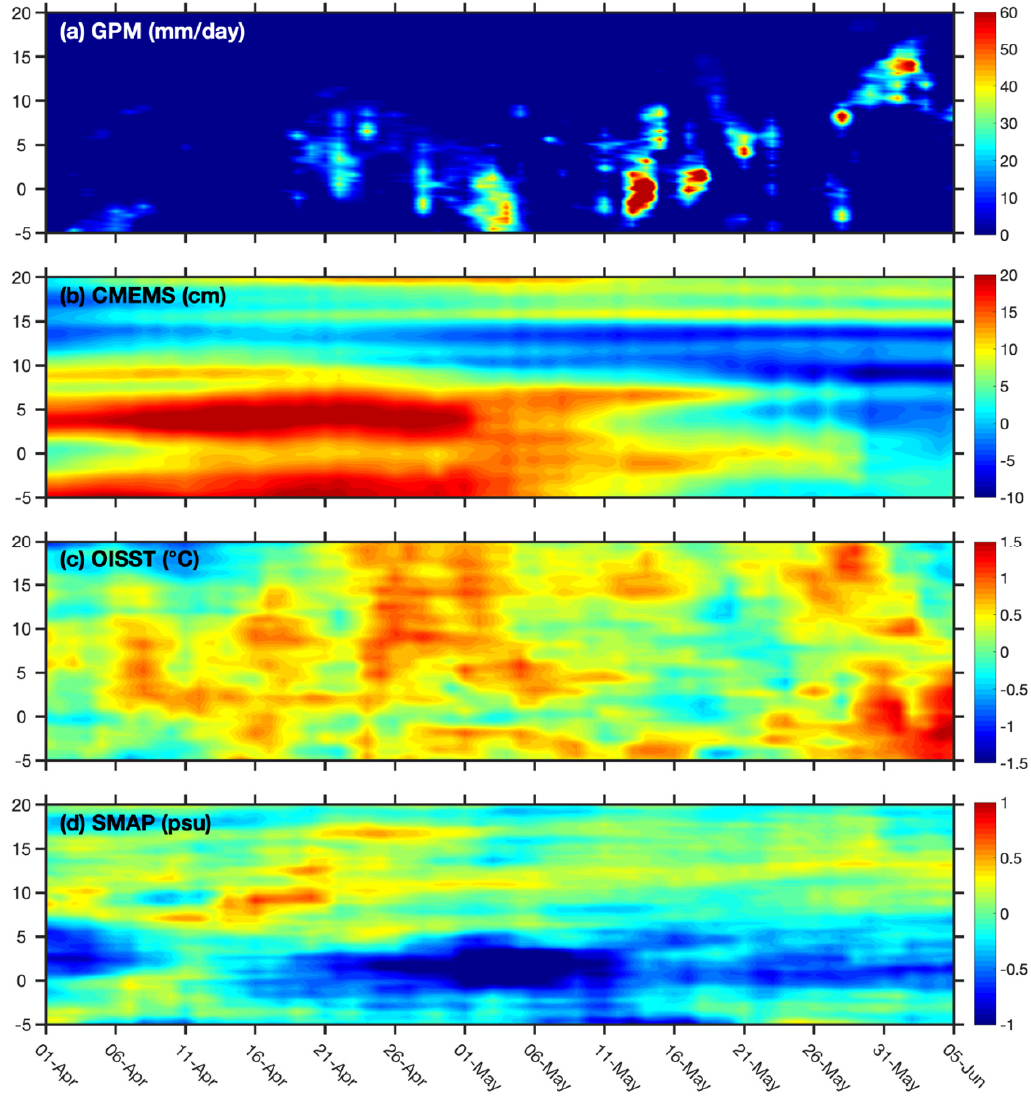
Figure 10. Time–latitude plots of ( a ) GPM precipitation rate (mm/day), ( b ) CMEMS SLA (cm), ( c ) ( ◦ C), and ( d ) SMAP SSS (psu) in the southeastern Arabian Sea (65–70 ◦ E, − 5–20 ◦ N) from April 1 OISST (°C), and ( d ) SMAP SSS (psu) in the southeastern Arabian Sea (65–70°E, − 5–20°N) from April